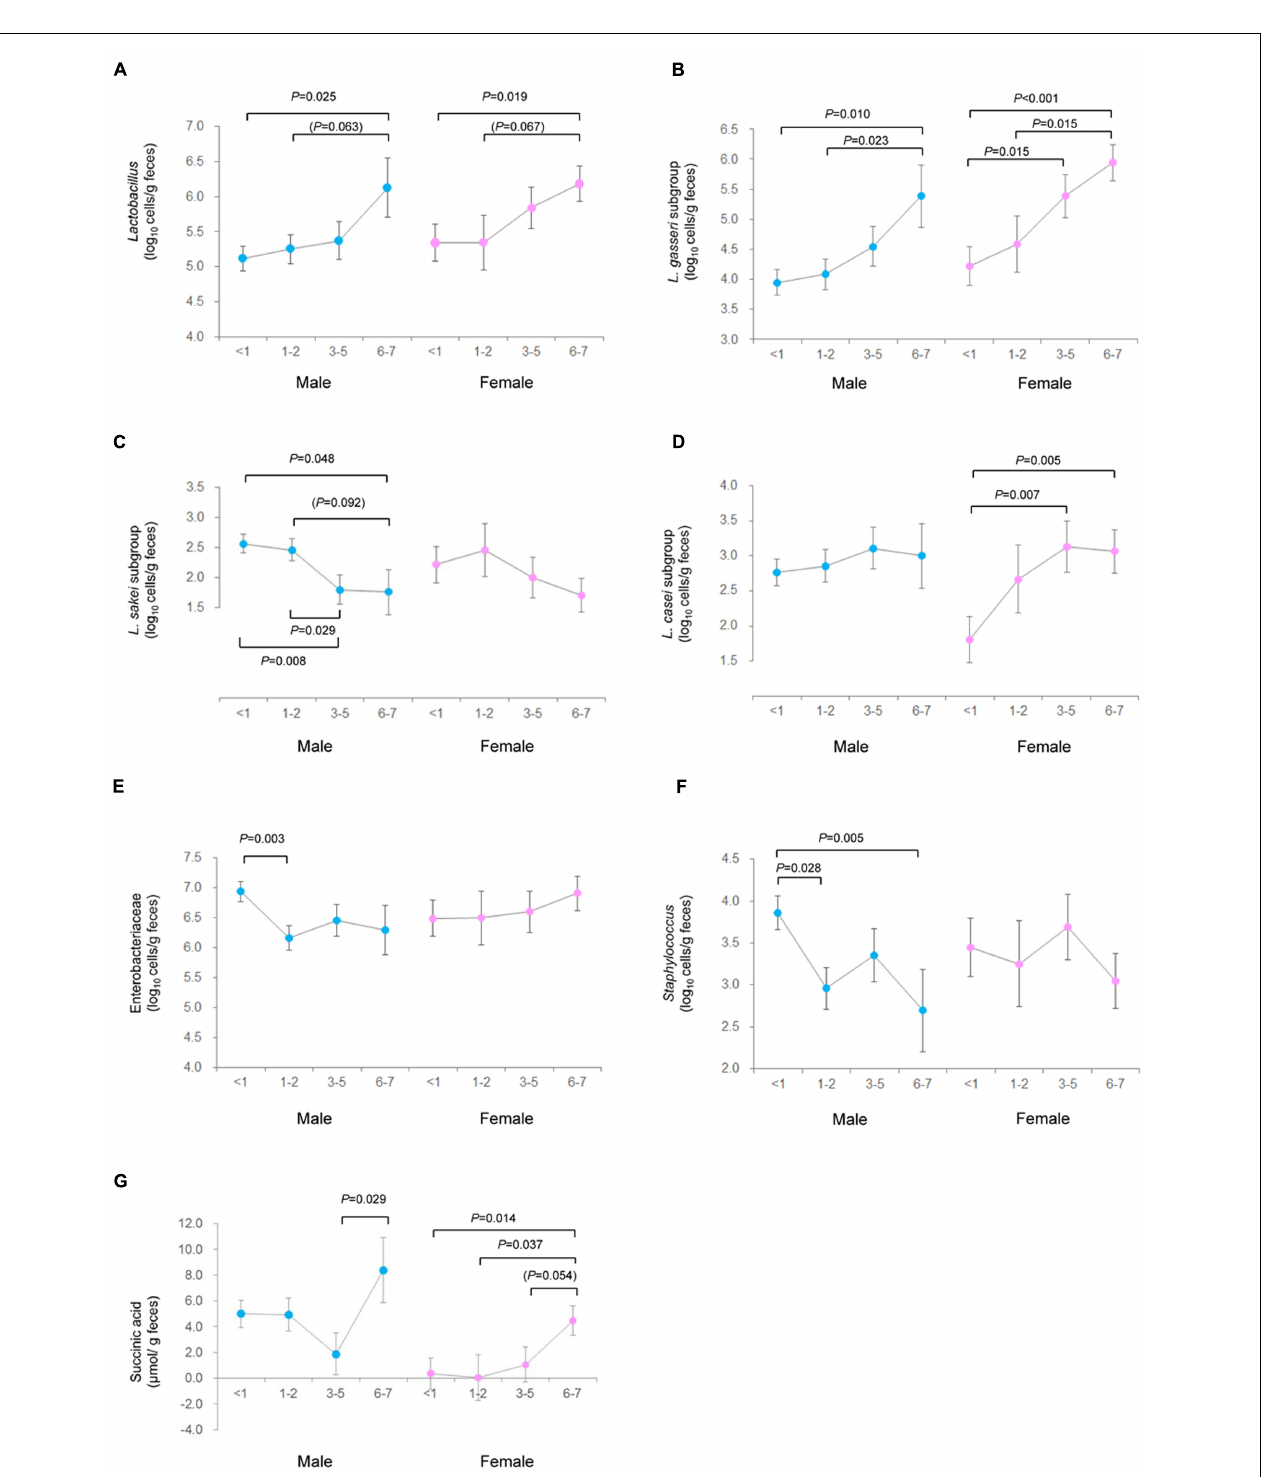
FIGURE 3 | Estimated marginal means of fecal bacterial count and organic acids concentration in male vs. female subjects profiled according to the frequency of yogurt consumption. (A) Lactobacillus; (B) L. gasseri subgroup; (C) L. sakei subgroup; (D) L. casei subgroup; (E) Enterobacteriaceae; (F) Staphylococcus; and (G) succinic acid. Variables showing significant linear association with yogurt consumption in male or female subjects are presented. Dots and error bas represent the marginal estimated mean and standard errors, respectively. Blue and pink dots represent male and female data. P -value indicates the significance tested by generalized linear model. In addition to P < 0.05, P < 0.1 is also presented in parenthesis.